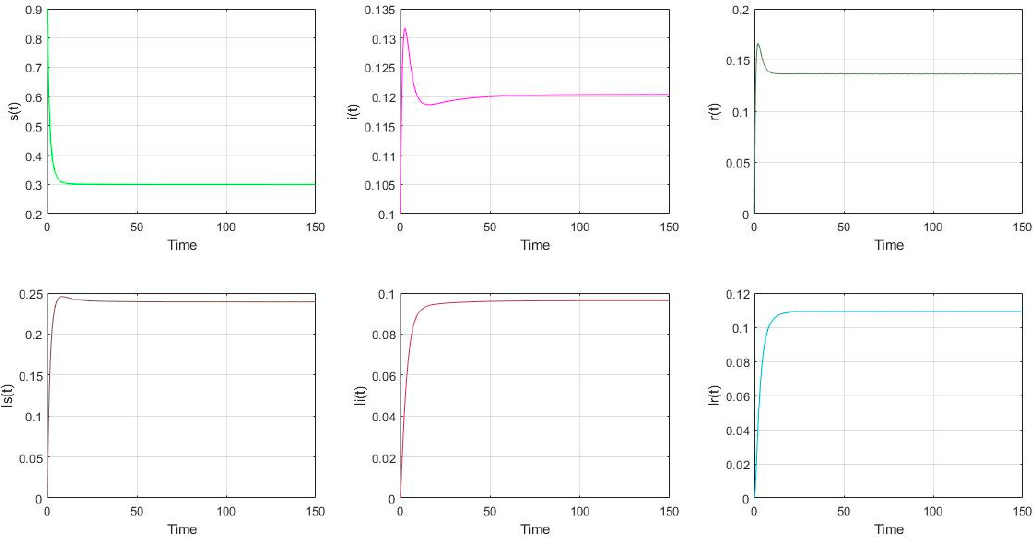
Figure 5. The distribution of nodes if R 0 = 1.3473 and β 2 = 0.2.